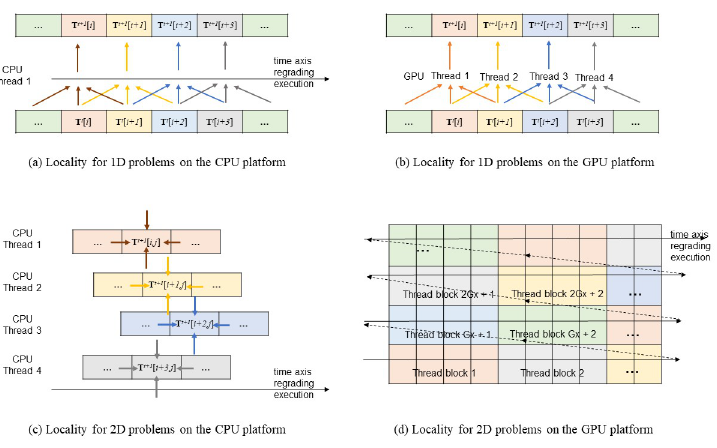
Fig 16. Locality of reference in optimal implementations. (a) Locality for 1D problems on the CPU platform. (b) Locality for 1D problems on the GPU platform. (c) Locality for 2D problems on the CPU platform. (d) Locality for 2D problems on the GPU platform.